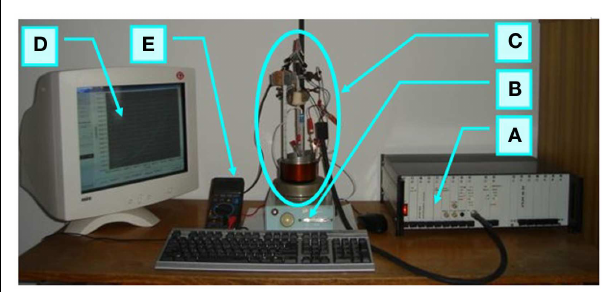
FIGURE 1 | Set-up used for standard electrochemical polishing EP:A, potentiostat; B, heating system; C, electrochemical cell; D, computer with software; E, digital multimeter